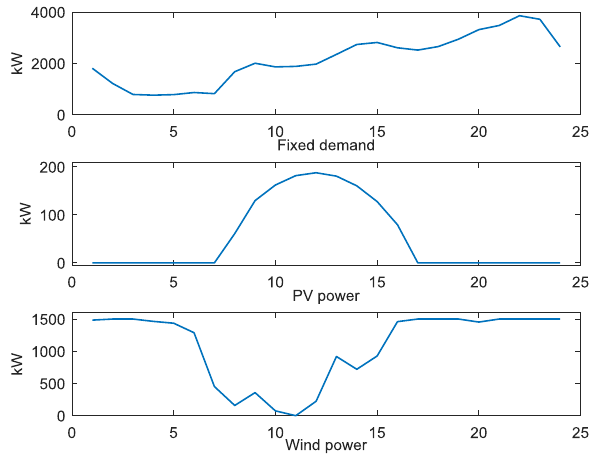
Figure 2. Basic trajectories of fixed demand, photovoltaics (PV), and wind power.